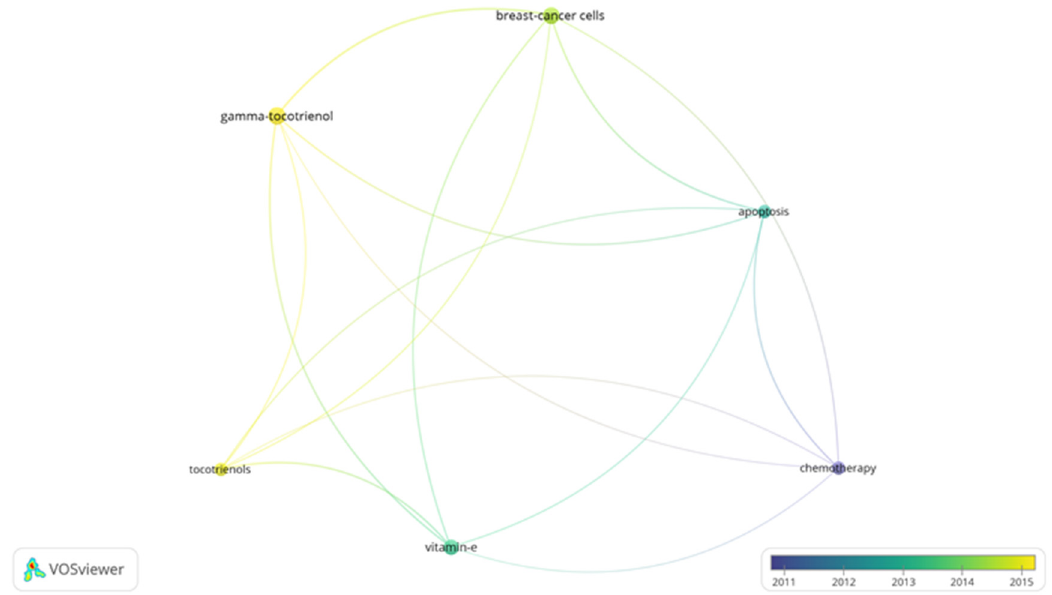
Figure 4. Term map for years 2011–2015 generated from Search 2. Visualization of 6 terms that occurred a minimum of 5 times in publications. Table S3 lists the visualized terms and their respective occurrences, average year of publication, and average number of citations.